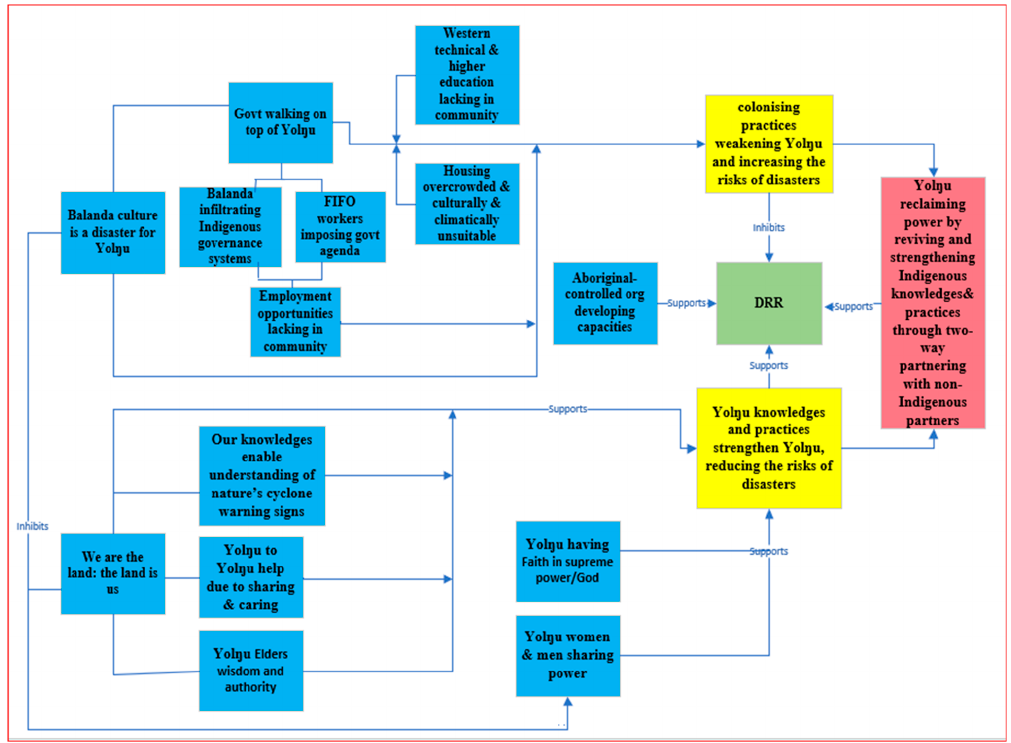
Figure 2. Grounded theory of Indigenous disaster risk reduction (DRR) in Galiwin’ku